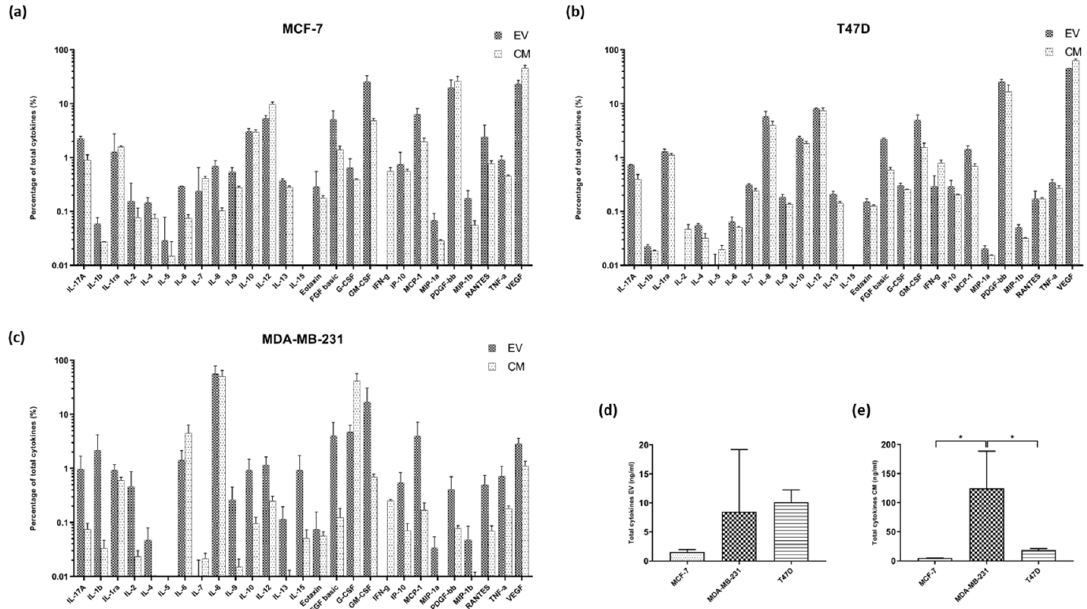
Figure 2. The percentage of the cytokines in each of the samples, calculated and the EVs and conditioned media (CM) for each sample directly compared to one another for the cancer lines ( a ) MCf-7, ( b ) MDA-MB-231 and ( c ) T47D on a log 10 scale. The cytokine load of from the cells ( d )